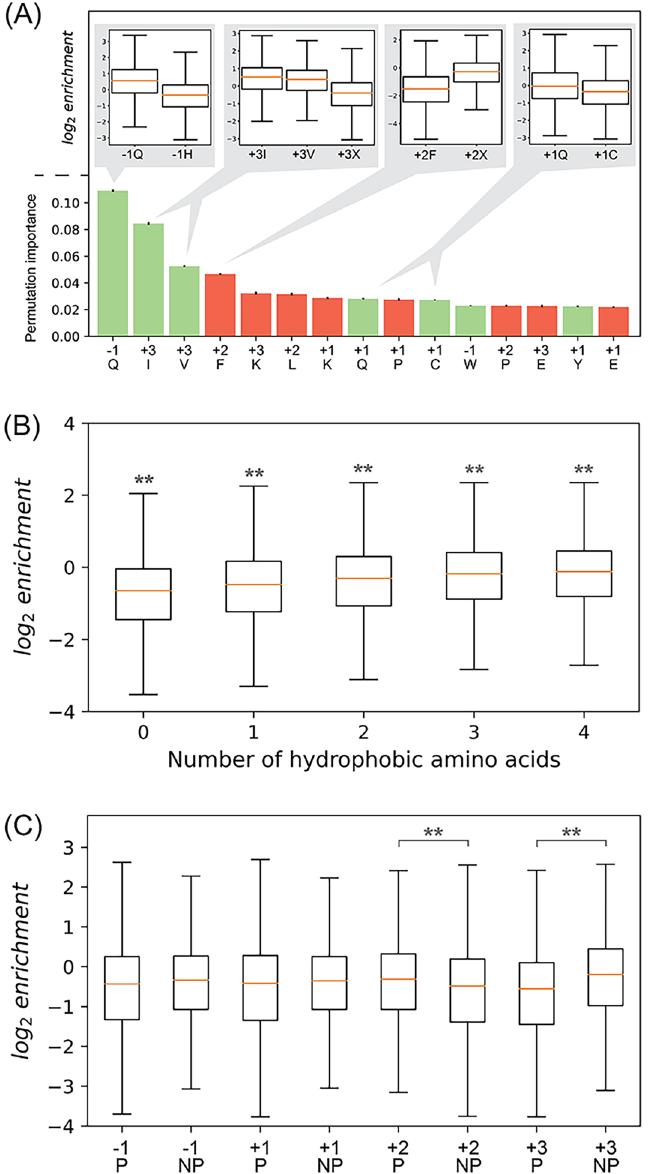
Figure 4. Analysis of the enriched peptides from Lib4. ( A ) Permutation importance for the amino acids used as input for a Random Forest Regression model, sorted by importance. The permutation importance indicates how important given amino acid is to accurately predict enrichment. Color of bars indicates association with enrichment: Green = important for increase of enrichment, red = important for decrease of enrichment. Bars are mean permutation importance for ten-fold cross-validated calculations. Insets represent enrichment differences at positions − 1, + 1, + 2 and + 3 when a particular amino acid is in that position (left side) and when any other amino acid is in that position (right side), and are significant as determined by independent T-test ( p < 0.01; n > 7000). X denotes any amino acid except the one analyzed in the bar/s to the left in each inset. ( B ) Effect of hydrophobicity on enrichment. Asterisks indicate significant difference to all other plots, determined by independent T-test ( p < 0.01; n = 7988–35,482). ( C ) Effect of polarity on enrichment. Amino acids with polar residues are denoted with P, and non-polar with NP. Asterisks indicate significant difference, determined by independent T-test ( p < 0.01; n > 70.000). Orange lines in all boxplots indicate median enrichment; boxes represent first and third quantile; whiskers represent 1.5 × inter-quantile